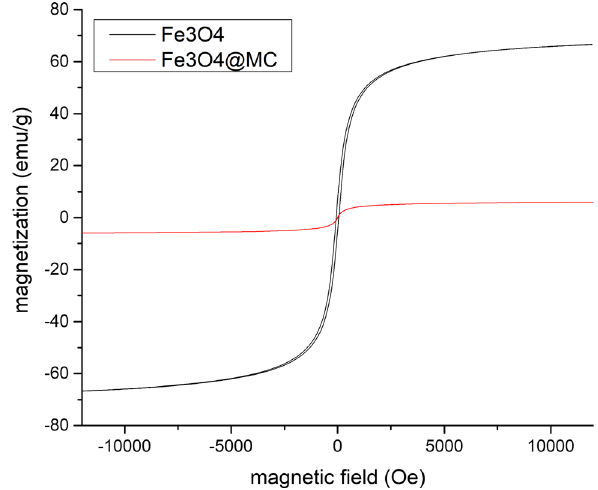
Fig. 2 Magnetization curve for Fe